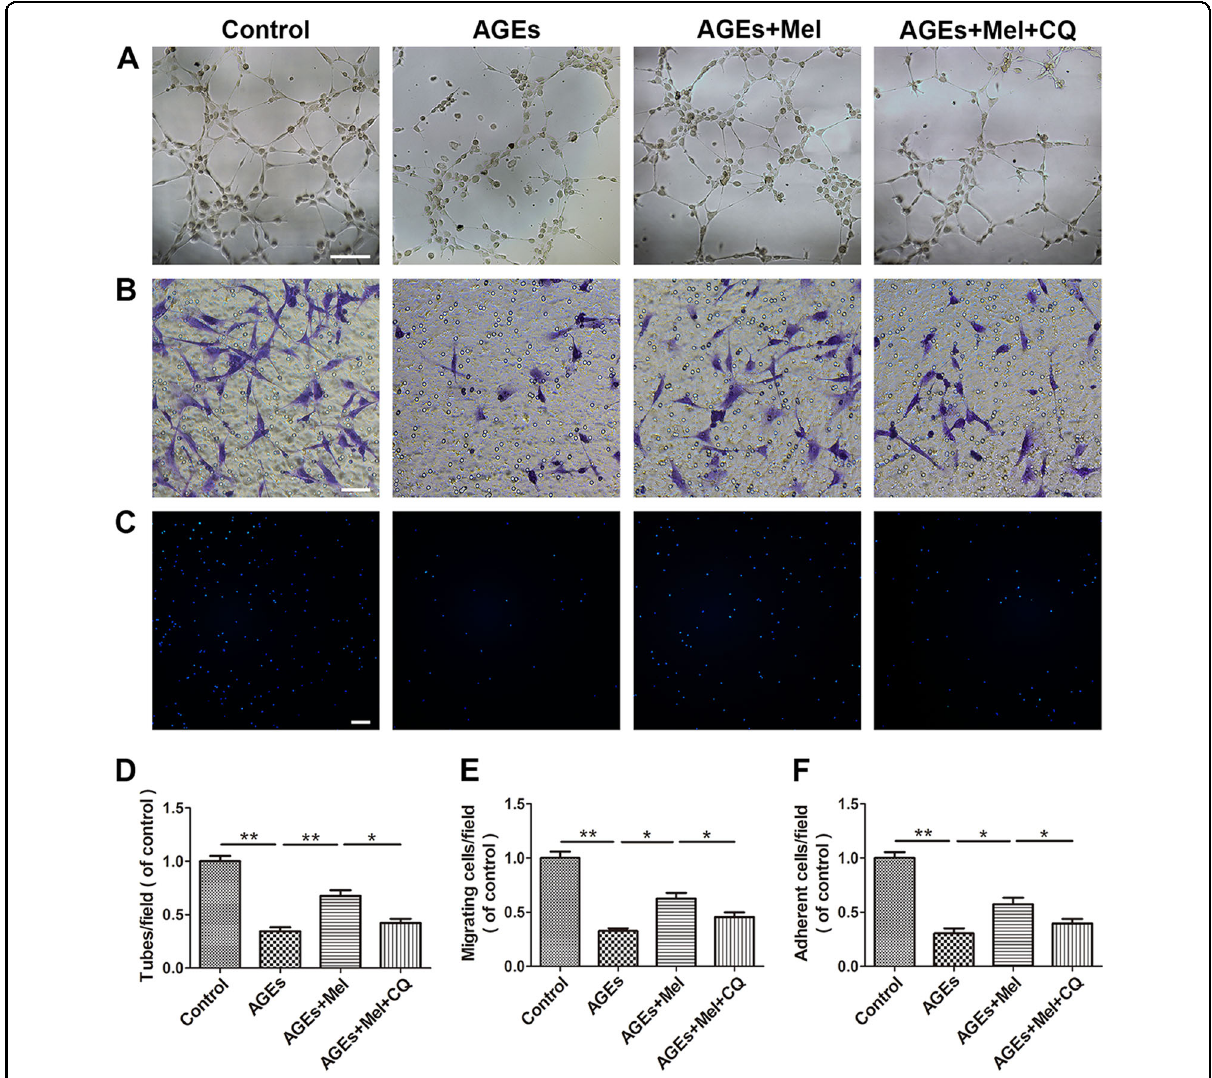
Fig. 4 Melatonin improves the function of AGE-treated EPCs by promoting autophagy fl ux. a , d A tube formation assay was used to investigate the effect of melatonin on EPC neovascularization. Scale bar, 50 μ m. b , e A transwell migration assay was used to study the effects of melatonin on EPC migration. Scale bar, 50 μ m. c , f An adhesion assay was performed to determine the effects of melatonin on adhesion in EPCs. Scale bar, 100 μ m. Data are presented as the mean ± SEM. Signi fi cant differences between the treatment and control groups are indicated as ** P < 0.01 or * P < 0.05. n =